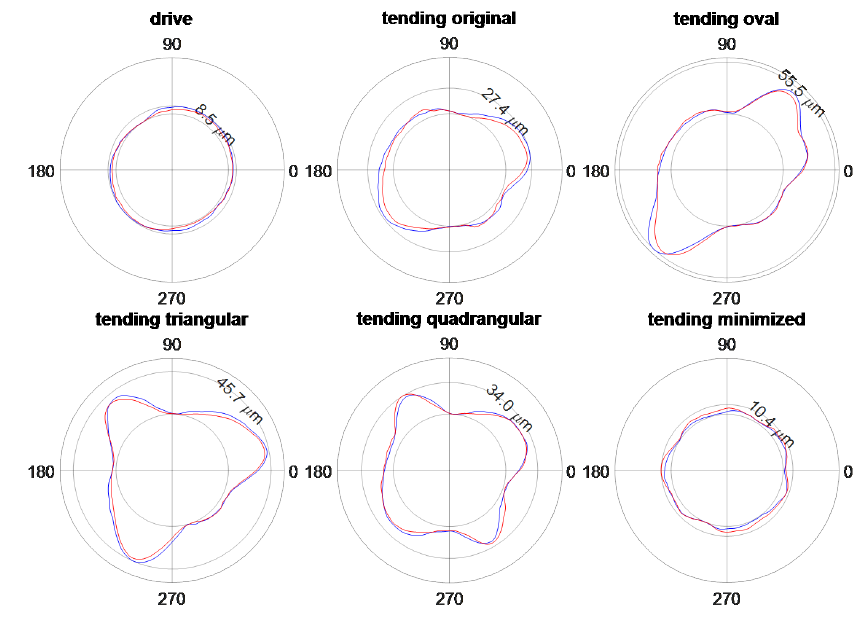
Figure 5. The roundness profiles of the installed bearing inner ring. The two profiles indicated in red and blue represent the roundness profiles in the middle of both roller paths of the bearing inner ring. The roundness error value in the figure represents the larger roundness error of the red and blue curve. The service end bearing inner ring was modified to five different geometries. The drive end bearing was not